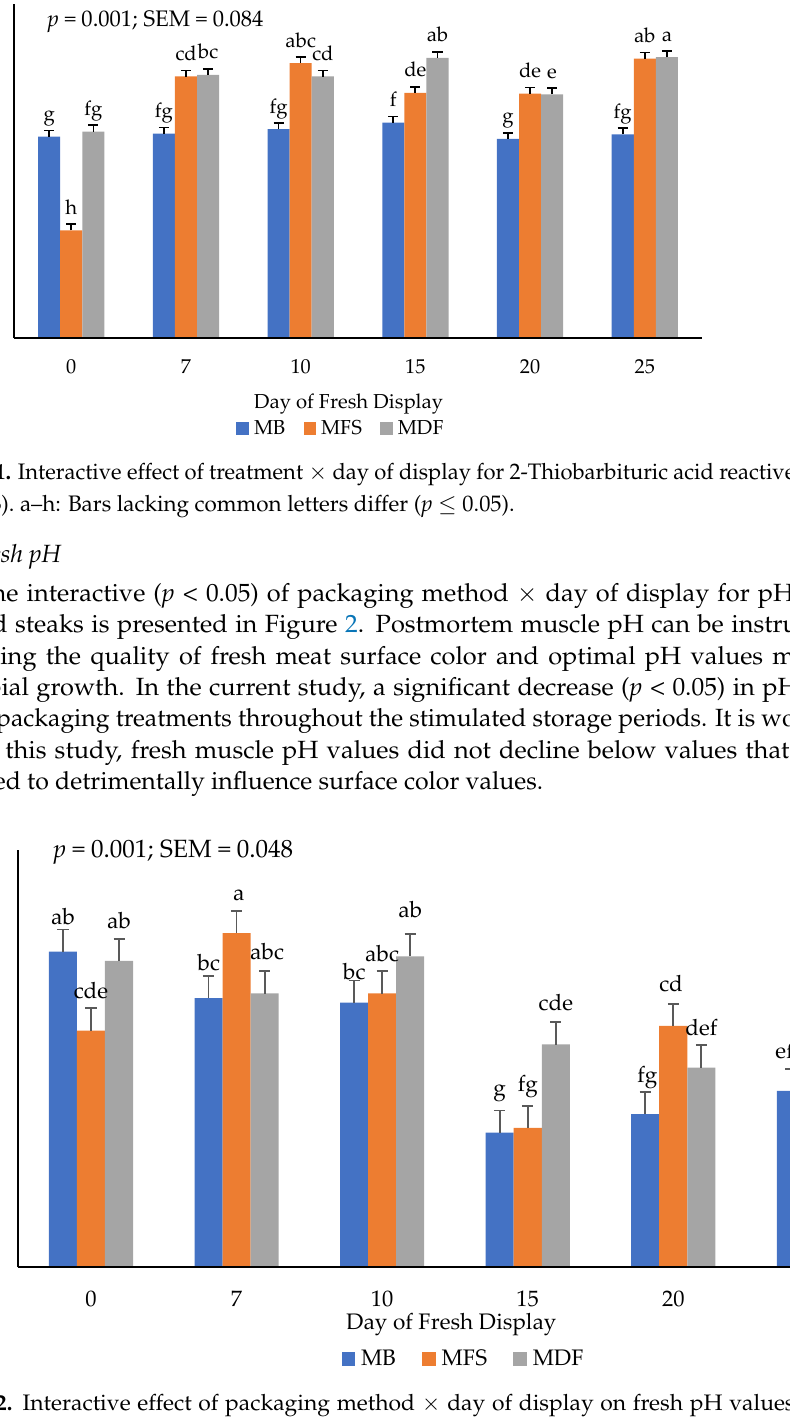
Figure 2. Interactive effect of packaging method × day of display on fresh pH values. a–g: Bars lacking common letters differ ( p ≤ 0.05).